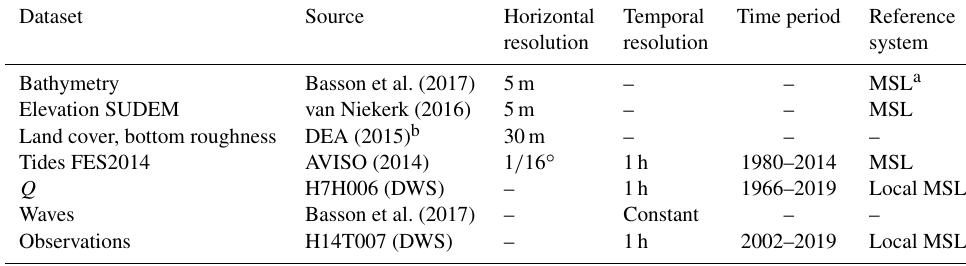
Table 1. Datasets and characteristics applied to set up Delft3D.